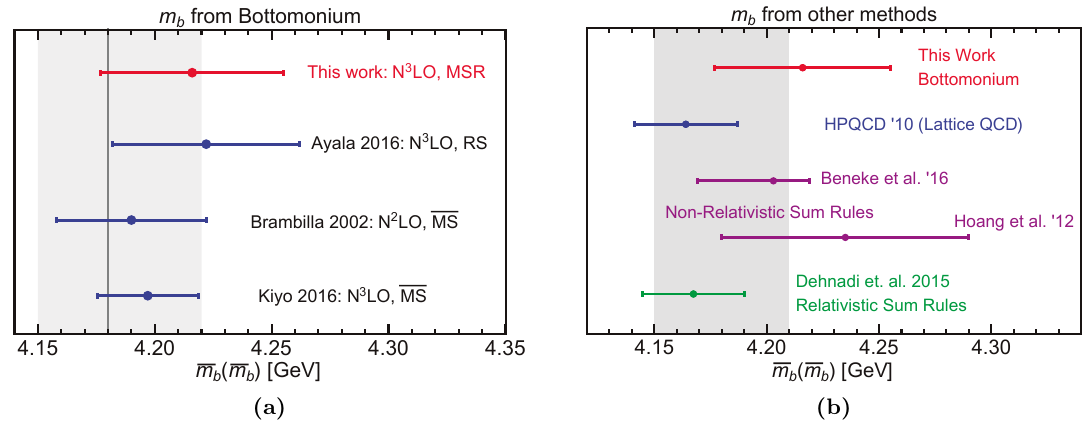
Figure 12. Comparison of our determination of the bottom MS mass (in red) with previous results from bottomonium (left) and other methods (right). Panel (a) compares a result at N 2 LO (second from the bottom in blue), with three results at N 3 LO. In these analyses various schemes for the bottom mass and di(cid:11)erent scale variations are used. Panel (b) shows the outcome of our analysis, a lattice determination (blue), two results from non-relativistic sum rules (purple) and one from relativistic sum rules (green). Both panels: the PDG world average value is shown as a vertical gray band. Note that the PDG world average has asymmetric